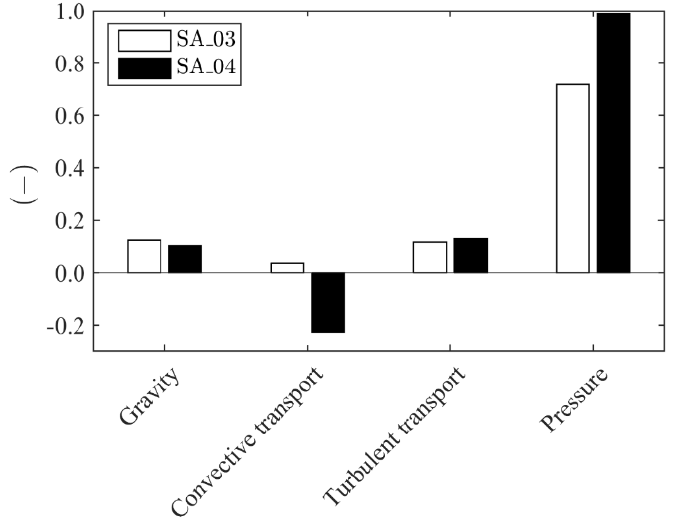
Figure 8. Net contributions (in percentage) of the terms in the right-hand side of Equation (4) to drag.